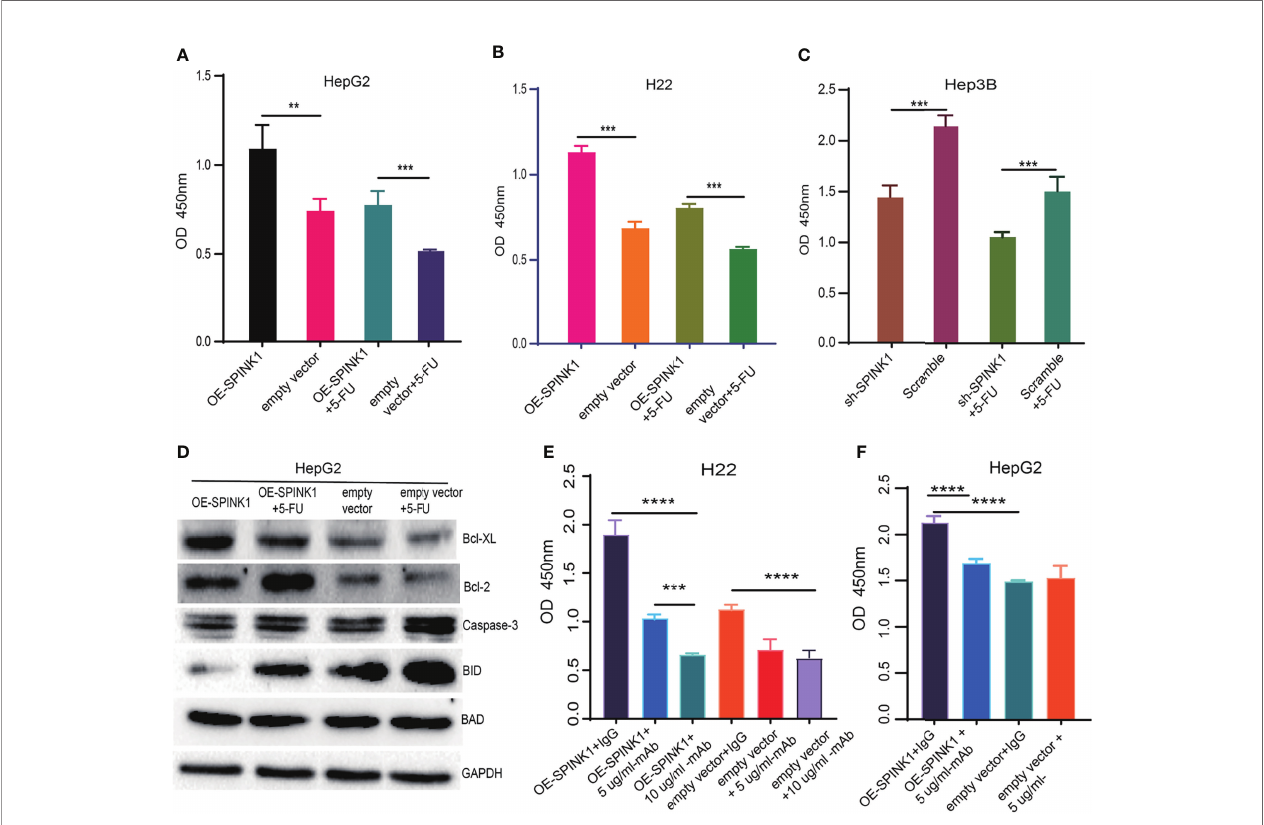
FIGURE 7 | SPINK1 -regulated chemoresistance, anti-apoptosis and SPINK1 -mAb targeting experiments. (A, B) SPINK1 enhanced chemoresistance in stable SPINK1 -OE HepG2 and SPINK1 -OE H22 cells following 24 h of exposure to 5-FU; (C) Decreased chemoresistance to 5-FU in SPINK1 knockdown Hep3B cells 24 h post-5-FU treatment. (D) Examination of apoptosis-related molecules including main pro- (Caspase 3, Bid and Bad) and anti-apoptotic regulators (Bcl-XL and Bcl- 2) using Western blot in SPINK1 -OE HepG2 and empty-vector control cells with or without 5-FU addition. (E, F) Targeting SPINK1 using anti-human SPINK1 - mAb in SPINK1 - OE H22 and - OE HepG2 cells, with IgG as an isotype control. Error bars represent mean ± standard deviation of independent experiments or the experiments performed in triplicates either in 6-well or 96-well plates. OD, optical density; **, P < 0.01; ***, P < 0.001; ****, P <